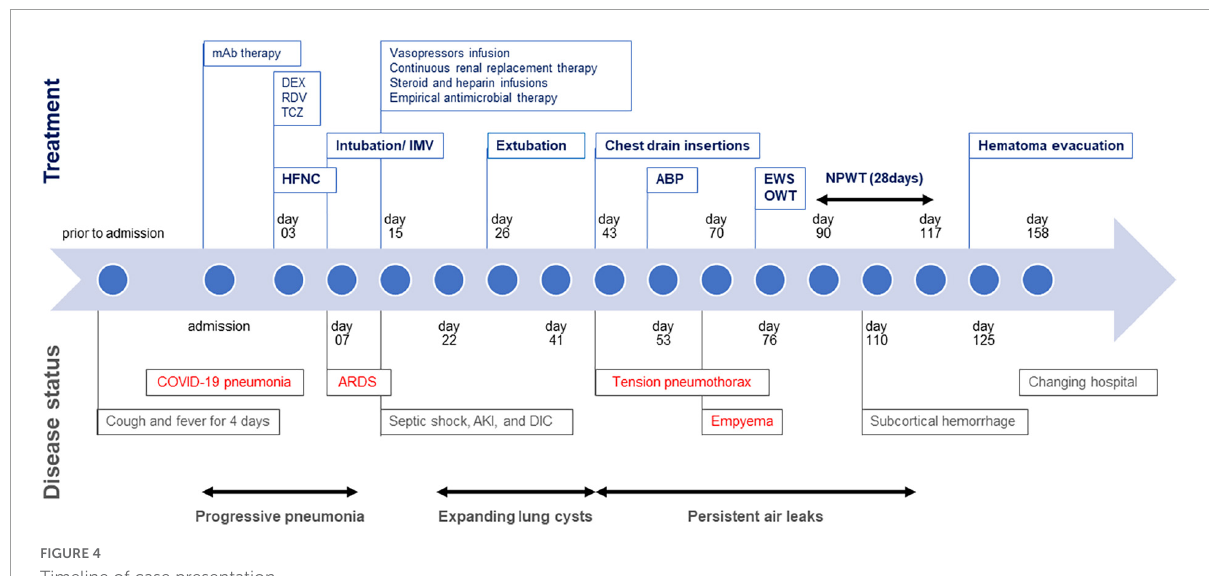
FIGURE4 Timeline of case